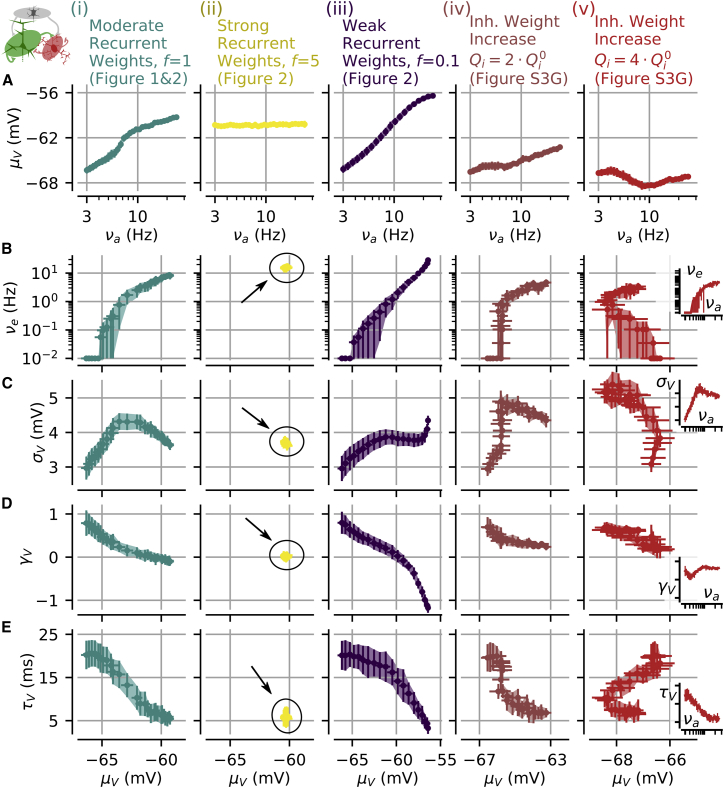
Relationship between Membrane Potential Features and Firing Rates for Different Parameter Settings of the Recurrent Network(A) Relationship between νa and μV for a model network with different parameter settings. Specifically, (i) moderate and balanced recurrent interactions (the architecture shown in Figures 1 and 2), (ii) strong and balanced recurrent interactions for f = 5 in Figure 2, (iii) weak and balanced recurrent interactions found for f = 0.1 in Figure 2, (iv) a moderately inhibitory-augmented case with Qi = 2⋅Qi0, and (v) a strongly inhibitory-augmented case with Qi = 4⋅Qi0.(B) Relationship between μV and νe in the different cases shown in (A).(C) Relationship between μV and σV under the different scenarios shown in (A).(D) Relationship between μV and γV.(E) Relationship between μV and τV. The mean ± SEM over 10 excitatory cells averaged over 10 network simulations lasting 1 s each is presented.The insets in (B)–(E) (v) show the dependency of νe, σV, γV, and τVon νa.See also Figure S4.